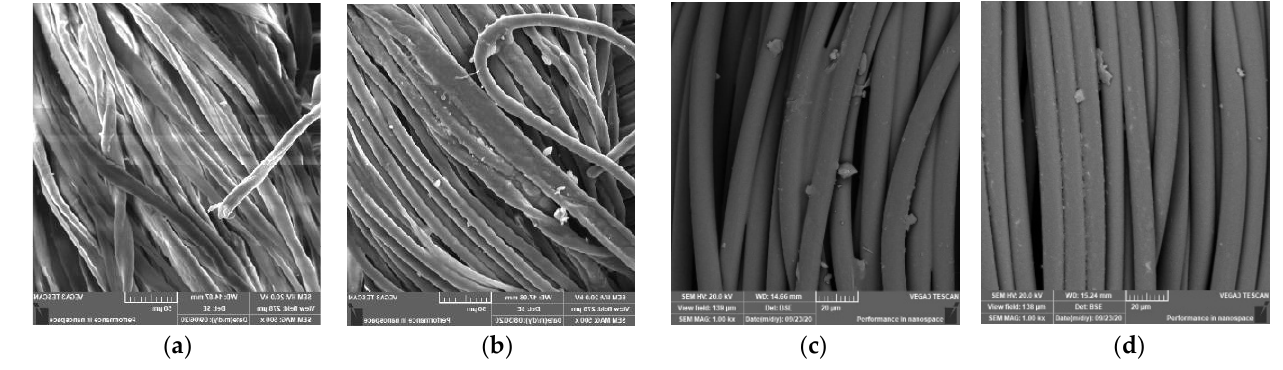
Figure 7. SEM images of: ( a ) untreated cotton fabric, ( b ) treated cotton fabric with CSNPs, ( c ) Acid Red 88 dyed cotton fabric with CSNPs, and ( d ) Acid Blue 317 dyed cotton fabric with CSNPs. The colour intensity, represented in K/S values, is proportional to the amount of dye absorbed at the cellulosic cotton surface. Acid Blue 318 dye has higher K/S values than Acid Red 88 dye, as seen in Figure 8, because it generates more cationic sites on the surface of cellulosic cotton thanks to CSNPs. Additionally, Figure 8b,c illustrates the similar